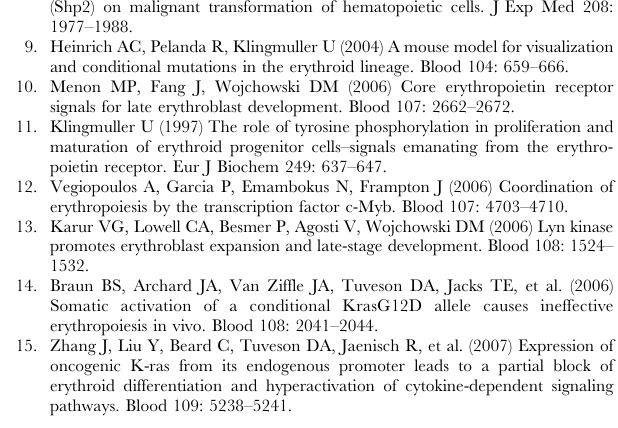
Figure S1 Generation of Ptpn11 D61Y mice . (A) Schematic of breeding for the generation of Ptpn11D61Y mice. (B) Assessment of STOP-cassette deletion in Ptpn11 D61Y mice. Hematopoietic cells were purified by FACS and DNA was extracted. Deletion of the STOP cassette was assessed by PCR (‘‘C’’, Epor , ‘‘D’’, Ptpn11 D61Y ). (PDF) Figure S2 Stress erythropoiesis in Ptpn11 D61Y mutant mice. (A) Epor (n= 7) and Ptpn11 D61Y (n= 5) mice were treated with PHZ for the indicated times and the kinetics of hematocrit changes were determined. (B–C) The frequency of CD71 + (B) and Ter119 + (C) in the spleens of Epor (n= 4) and Ptpn11 D61Y (n= 3) mice were determined at the indicated times following PHZ treatment. Data are presented as mean 6 SD, and were analyzed by analysis of variance (ANOVA) with Bonferroni post-hoc test; *p #